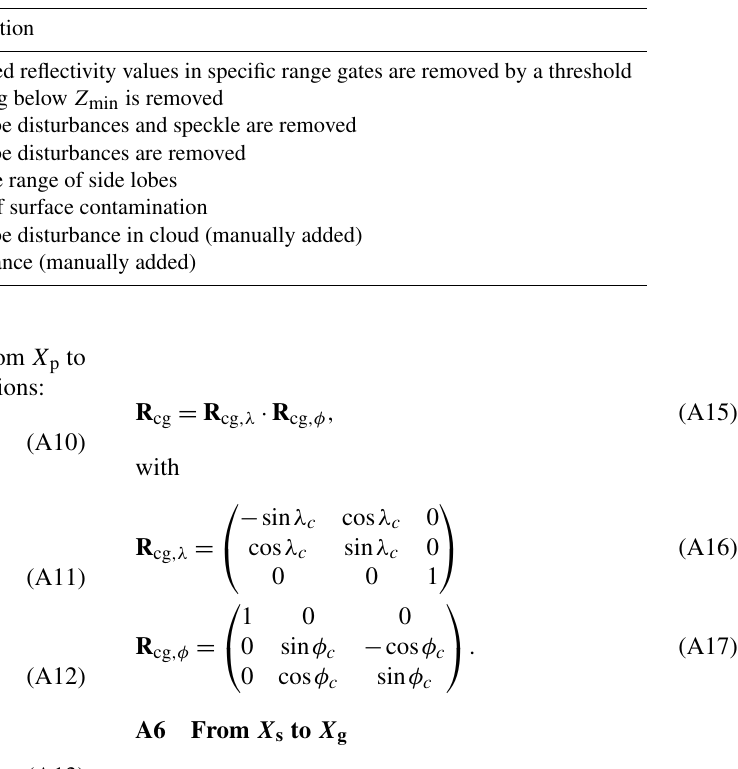
Table A1. Filter names and quality control of data in PANGAEA files (Kliesch and Mech, 2019), description to variable “Ze flag” rows 1 to 4 is already applied to get from “Ze unfiltered” to “Ze” and rows 5 to 8 help for analyzing the